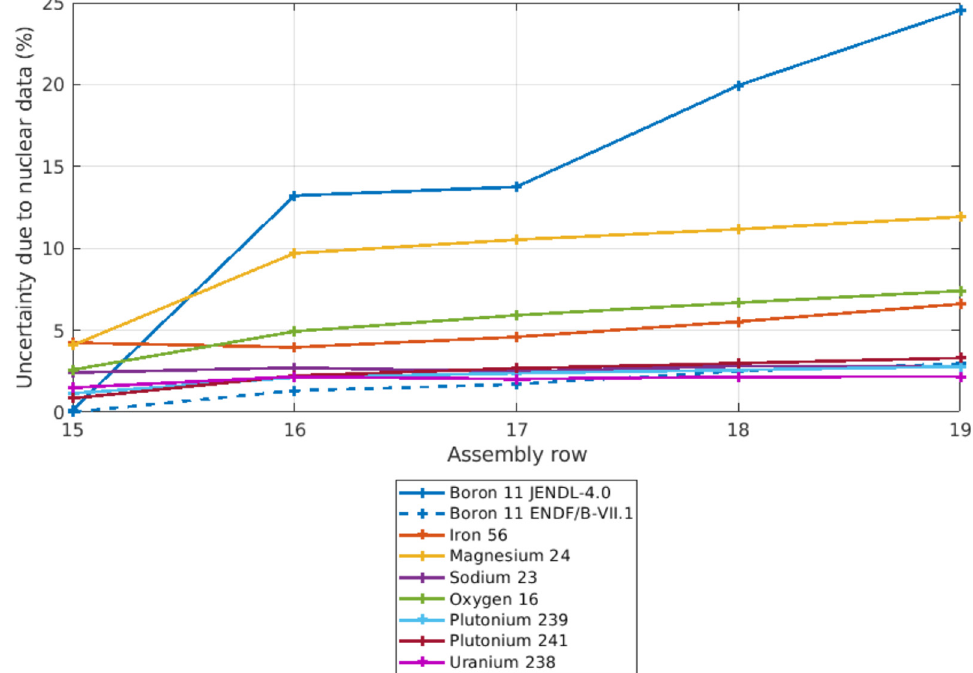
Fig. 31. Uncertainty by isotope due to nuclear data on the production of alpha particles in the neutron shielding